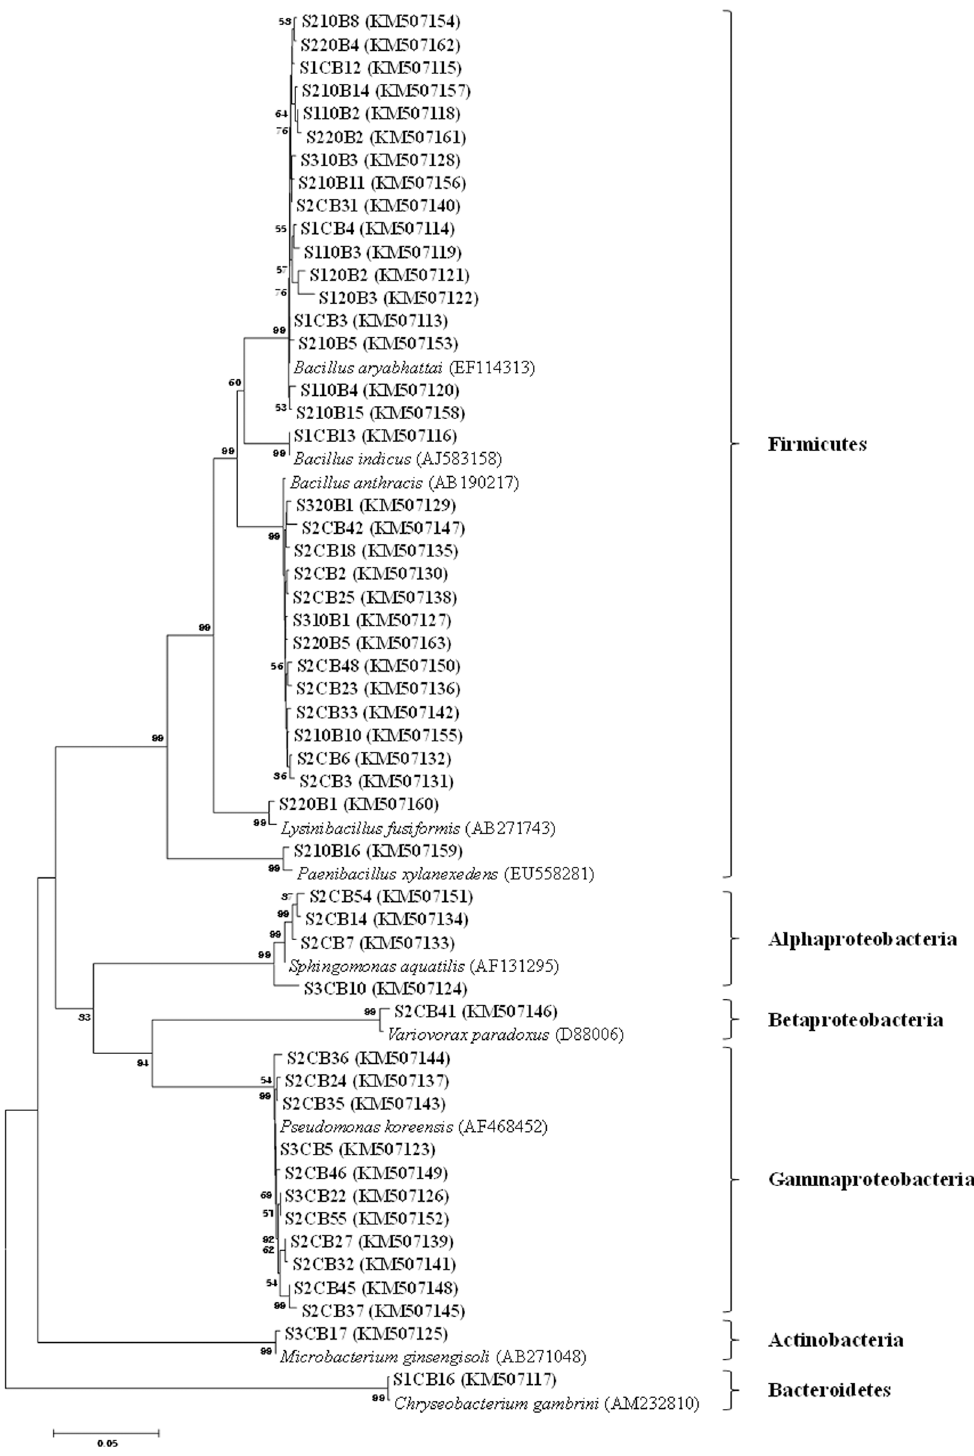
Fig 5. Neighbor-joining phylogenetic tree based on 16S rDNA sequence analysis, illustrating phylogenetic relationship of spore associated bacteria isolated from spore walls of AMF. SAB isolated from three types of spores at different disinfection time intervals possessing a minimum of three association characters were sequenced. The numbers at the nodes indicate the bootstrap support levels based on a neighbor joining analysis of 1000 resampled data sets. The SAB 16S rDNA sequences obtained from AMF